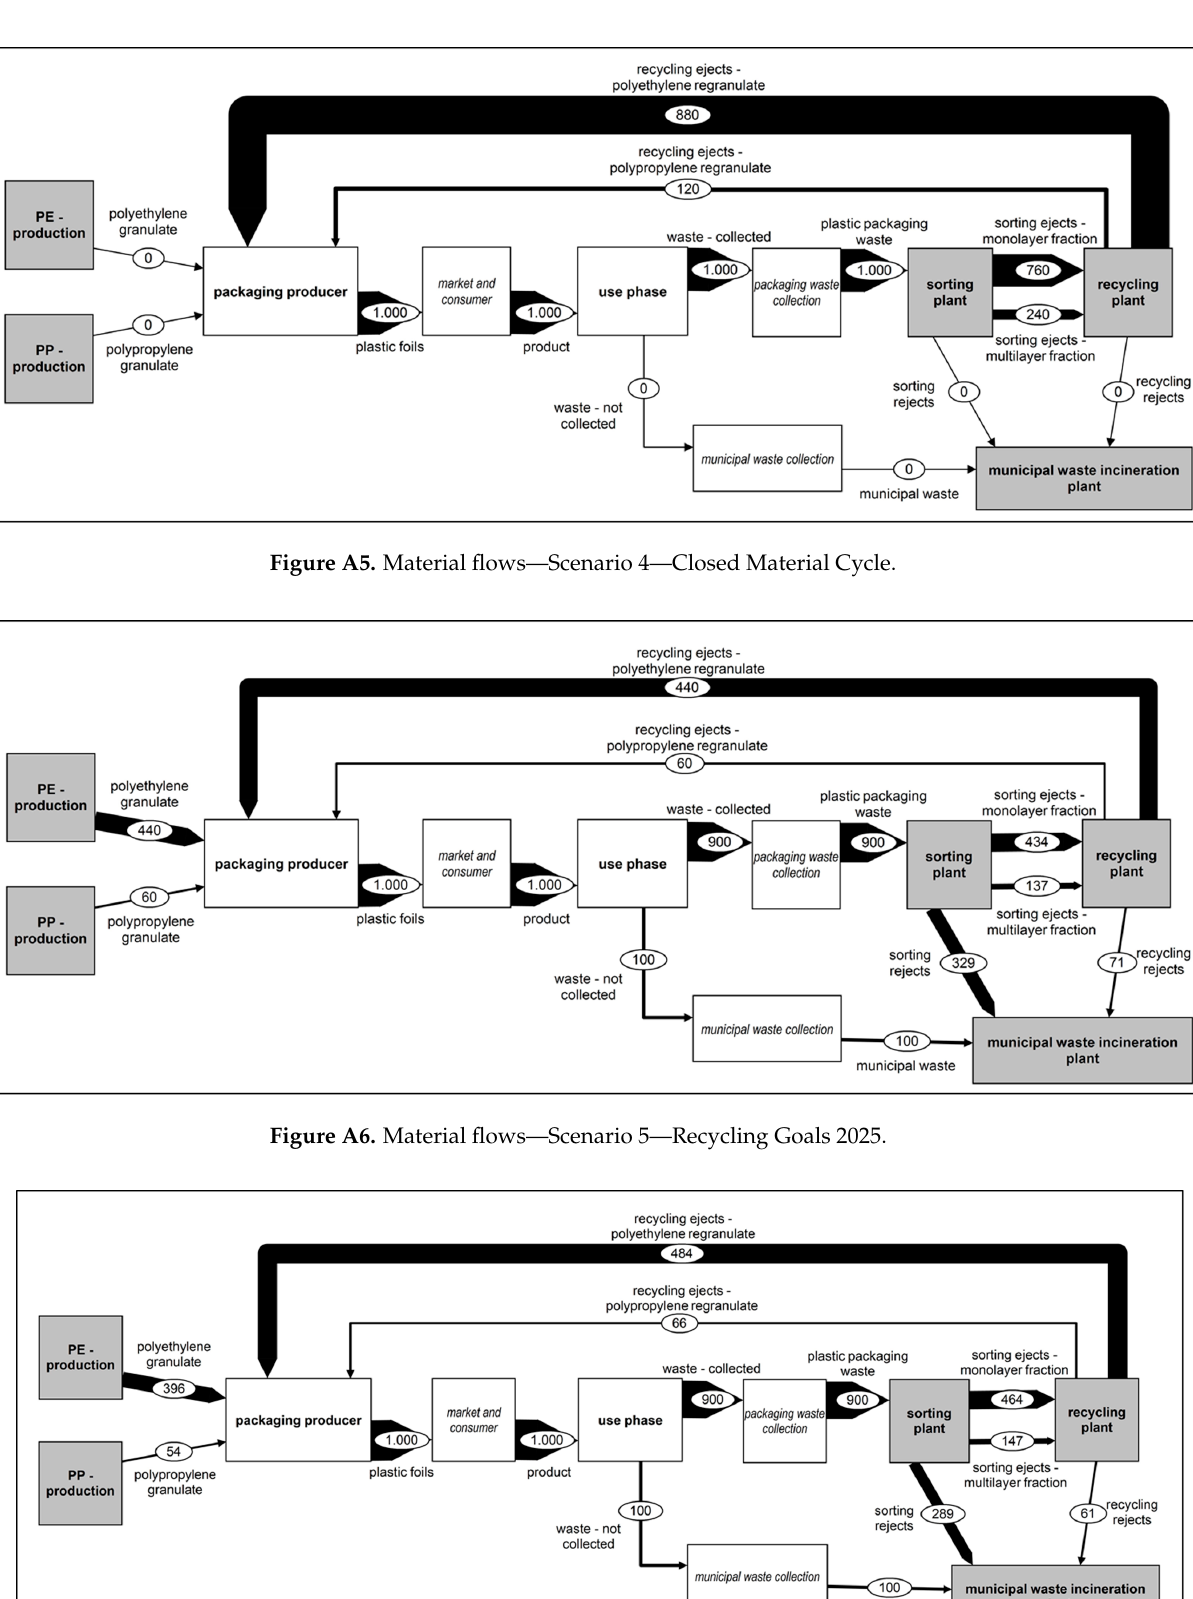
Figure A7. Material flows—Scenario 6—Recycling Goals 2030.